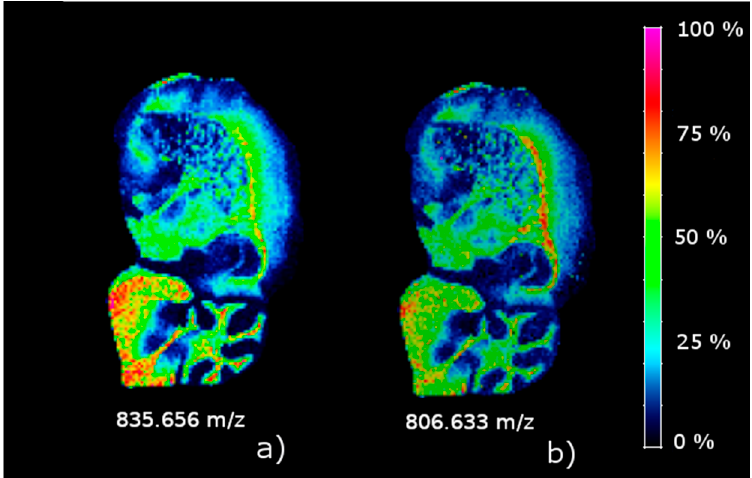
Figure 4. Concentration images of the two absolutely up-regulated ions in C2. (a) m/z 835.656; (b) m/z 806.633.